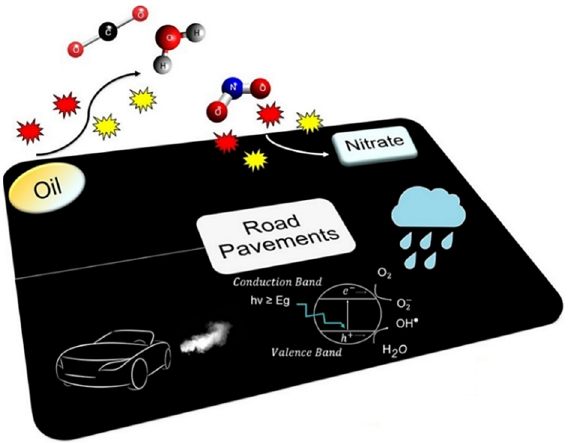
Figure 3. Photocatalytic asphalt mixture. Reprinted with permission from [8] Copyright 2018 Elsevier.